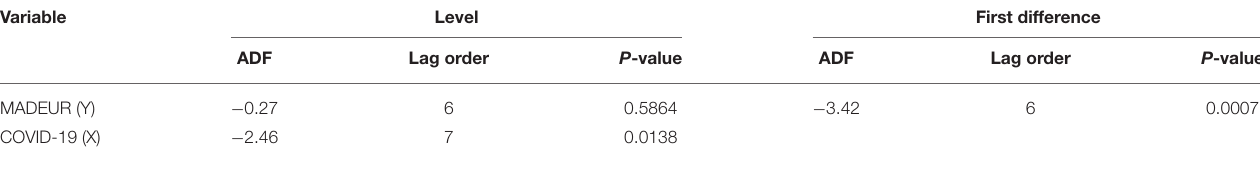
TABLE 1 | Stationarity test for MADEUR and COVID-19 new cases using ADF test.